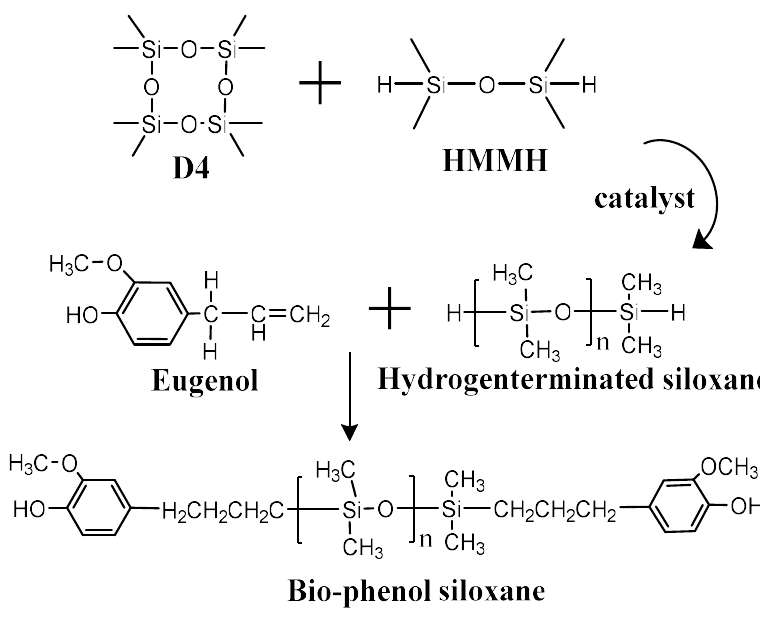
Figure 1. Scheme of synthesis of bio-phenol terminated organosiloxane.